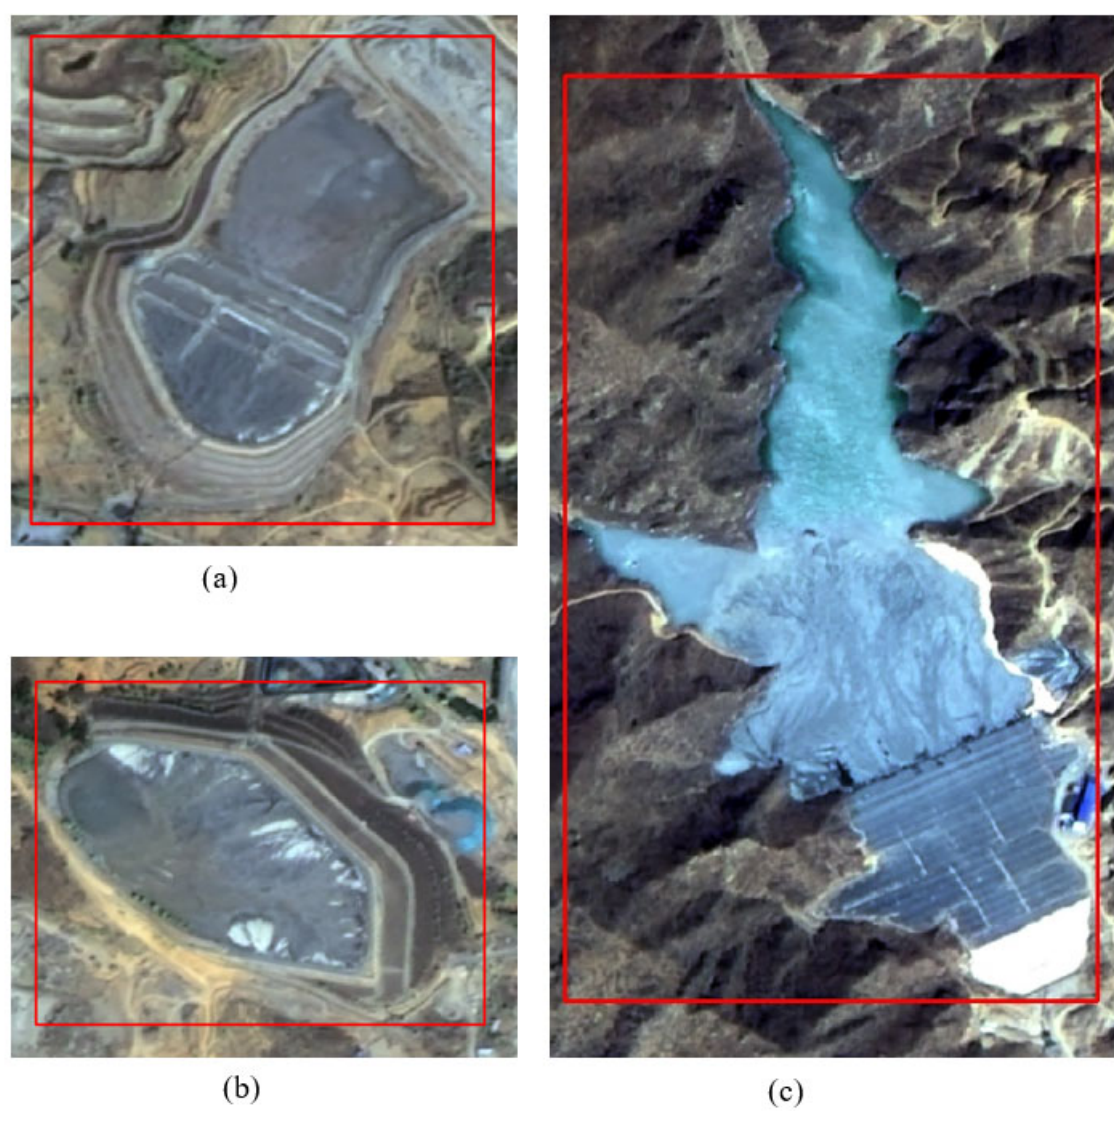
Figure 2. GF-1 image of sample tailings pond features, with the ground truth bounding boxes shown in red: ( a ) stockpile type; ( b ) hillside type; and ( c ) cross ‐ valley type.